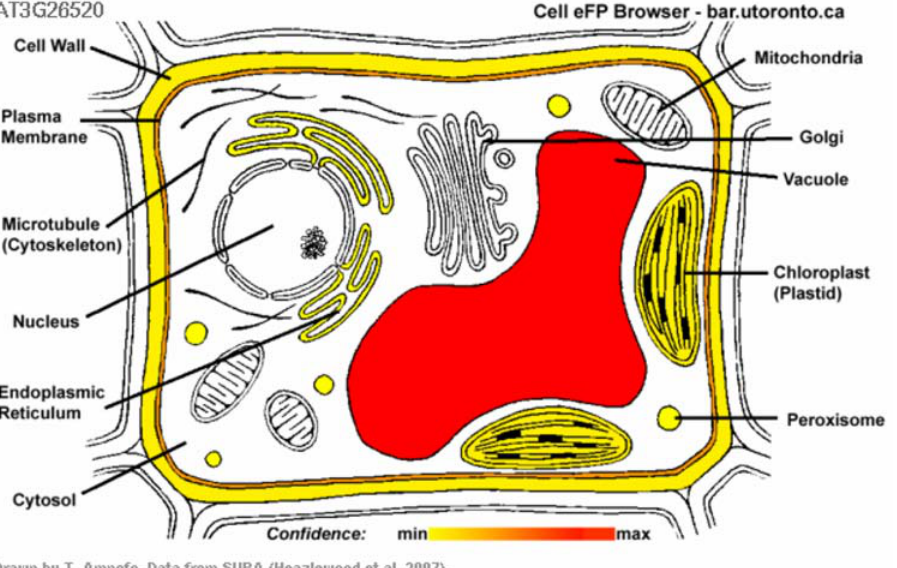
Figure 8. An exemplary Arabidopsis Cell eFP Browser output image. The subcellular localisation pattern of At3g26520, encoding Tonoplast Intrinsic Protein 2, false coloured according to degree of support for a given location based on both measured and predicted subcellular localizations from the SUBA database.